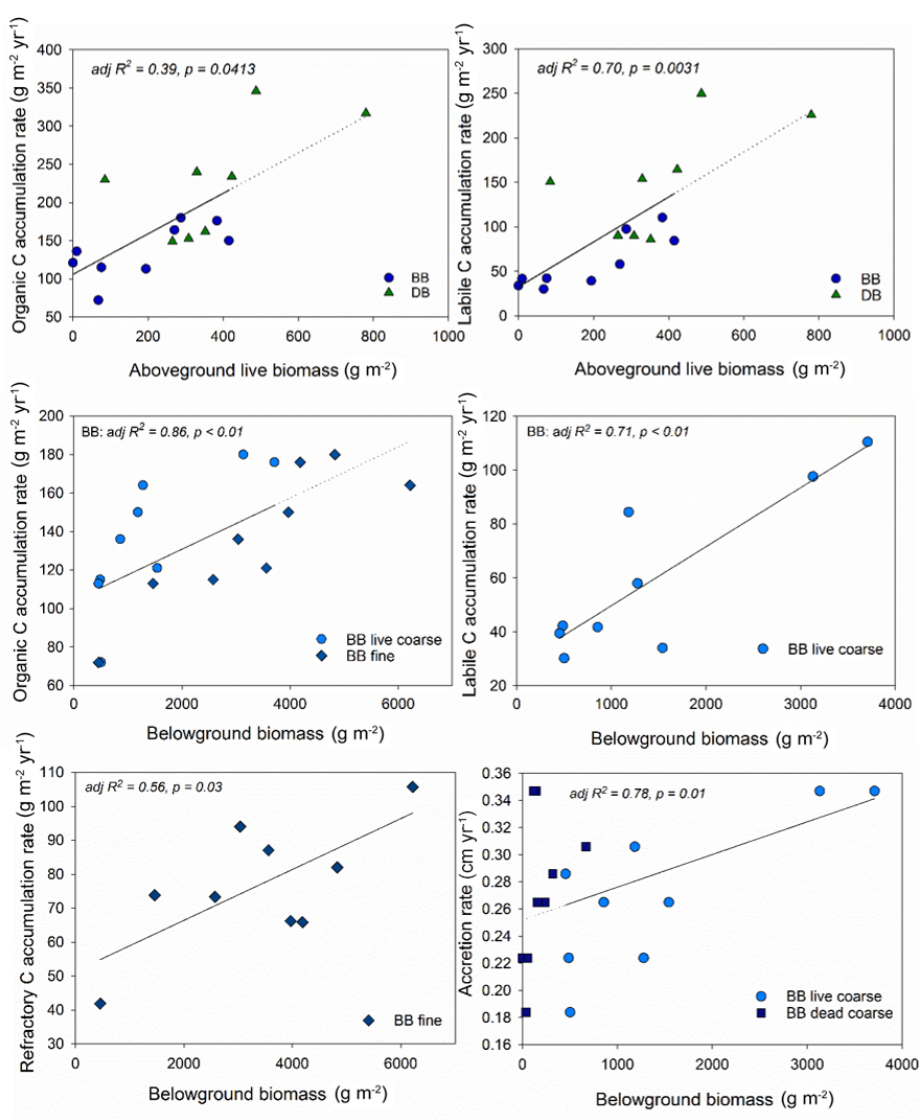
Figure 7. Relationship between Spartina alterniflora biomass and organic C (total, labile, and refractory) accumulation and accretion rate in marshes of Barnegat Bay (BB) and Delaware Bay (DB). Only significant ( p <0.05) relationships are